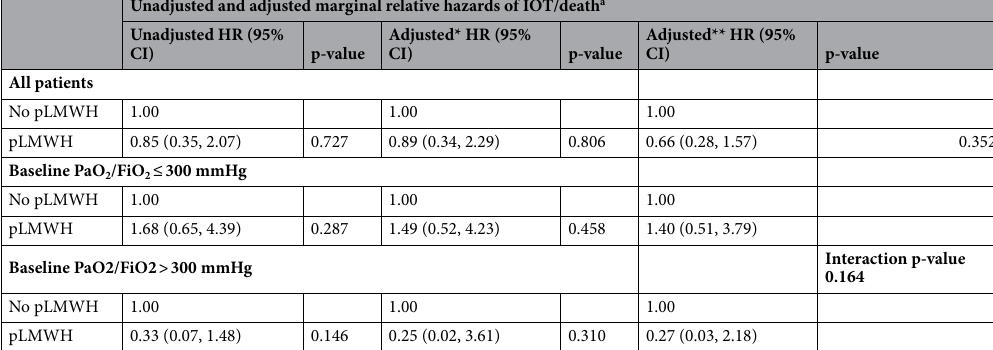
Table 2. Hazard Ratio of oro-tracheal intubation/death (OTI/death) in all population and according to PaO 2 / FiO 2 at admission. pLMWH prophylactic dose of low molecular weight heparin. *Adjusted for time-fixed factors: age, gender, time from symptoms onset, comorbidities (cardiovascular diseases, hypertension, COPD/ Asthma, diabetes), PaO 2 /FiO 2 at admission. **Adjusted for time-fixed and time varying factors: age, gender, time from symptoms onset, comorbidities (cardiovascular diseases, hypertension, COPD/Asthma, diabetes), PaO 2 /FiO 2 at admission, time-varying use of immune-therapy, antiviral and steroids and censoring using IPW. a Initiation of invasive mechanical ventilation or death.